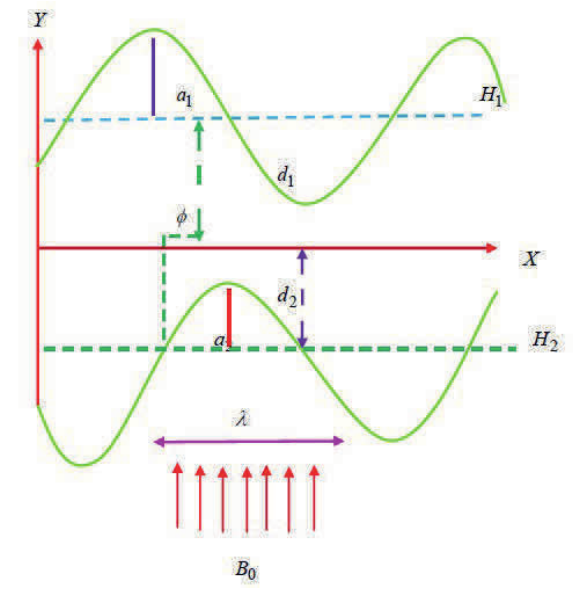
Fig. 1: Physical model of the problem.